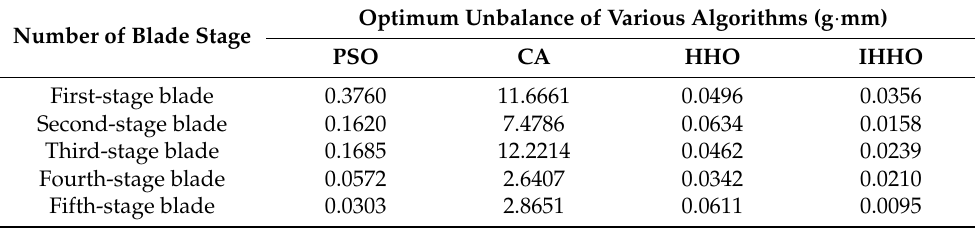
Table 6. Comparisons of optimization algorithms for rotor blade assembly at various stages.